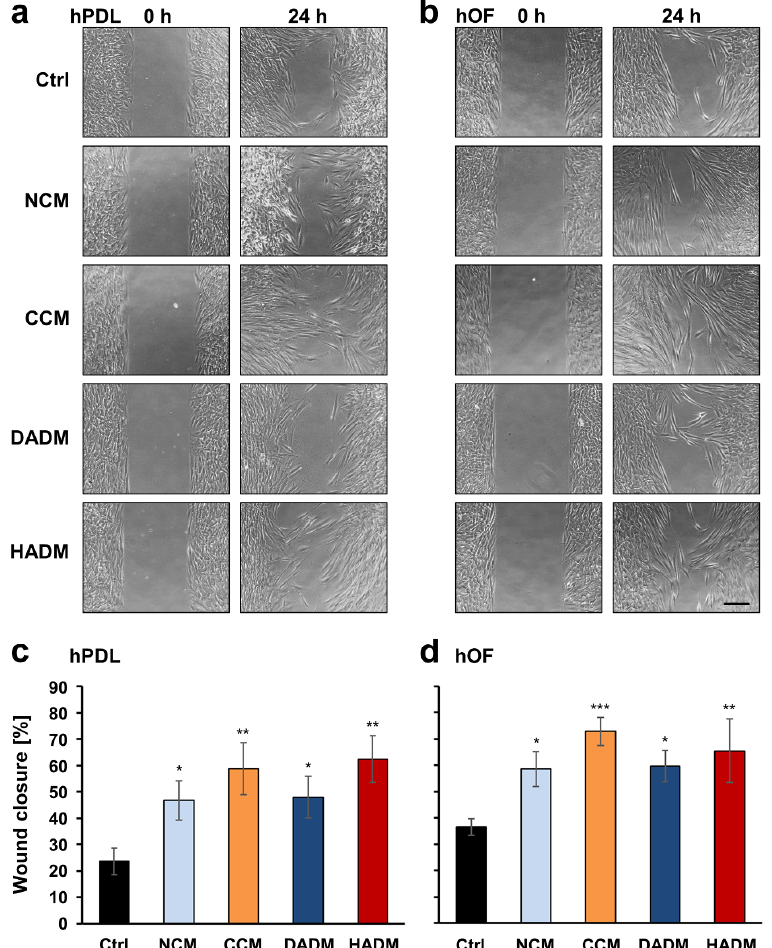
Figure 2. Enhanced wound healing potential of primary human oral cell types covered with four different collagen matrices. ( a , b ) Migration of hPDL ( a ) and hOF ( b ) cells toward an wound gap with a 500 µm width generated by seeding cells in a 2-well ibidi culture inserts, in the absence (Ctrl) or in the presence of NCM, CCM, DADM, and HADM matrices placed over the cells. Representative images of the two cell types in each of the experimental groups at 0 and 24 h are shown. Scale bar, 500 µm. ( c , d ) Bar charts presenting quantification of the wound healing potential of hPDL ( c ) and hOF ( d ) cells, in the absence or presence of collagen matrices, by measuring the cell-free area at 0 and 24 h. Percentage of wound closure was calculated as described in the Materials and Methods section. Data represent means ±SD from three independent experiments performed with three different cell donors, in triplicates. Significant differences to the control cells, *** p < 0.001, ** p < 0.01, * p < 0.05.